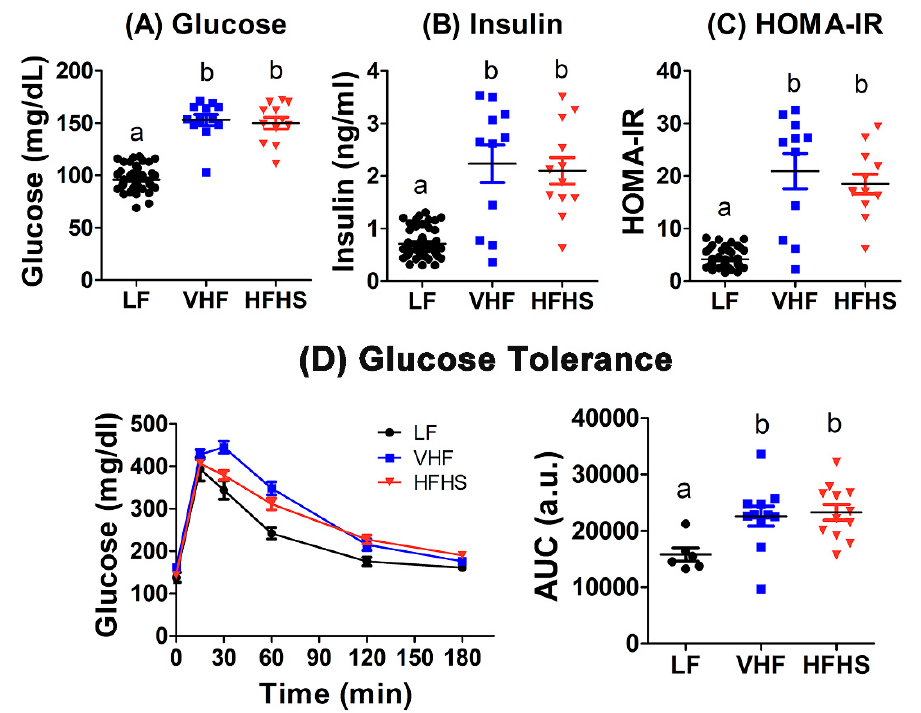
Figure 3. Diet effects on plasma glucose, insulin, and insulin resistance. Male C57BL/6J mice were fed low fat (LF), very high fat (VHF), or moderately high fat with excess sucrose (HFHS) diets for 12 weeks. Fasting blood glucose ( A ) and insulin ( B ) levels were determined from 49 LF-fed mice and 12 VHF-fed and 12 HFHS-fed mice. ( C ) The glucose and insulin data from each mouse were used to calculate HOMA index of insulin resistance (HOMA-IR). ( D ) a bolus glucose solution (2 g/kg body weight) was administered intraperitoneally to 6 LF-fed mice, 11 VHF-fed mice, and 12 HFHS-fed mice. Blood glucose levels were monitored over a 3 h period to determine glucose tolerance. Area under the curve (AUC) analysis of the data was used for statistical evaluation. Data groups with letter a are significantly different from data groups with letters b at p = 0.01 (1-way ANOVA with Bonferroni